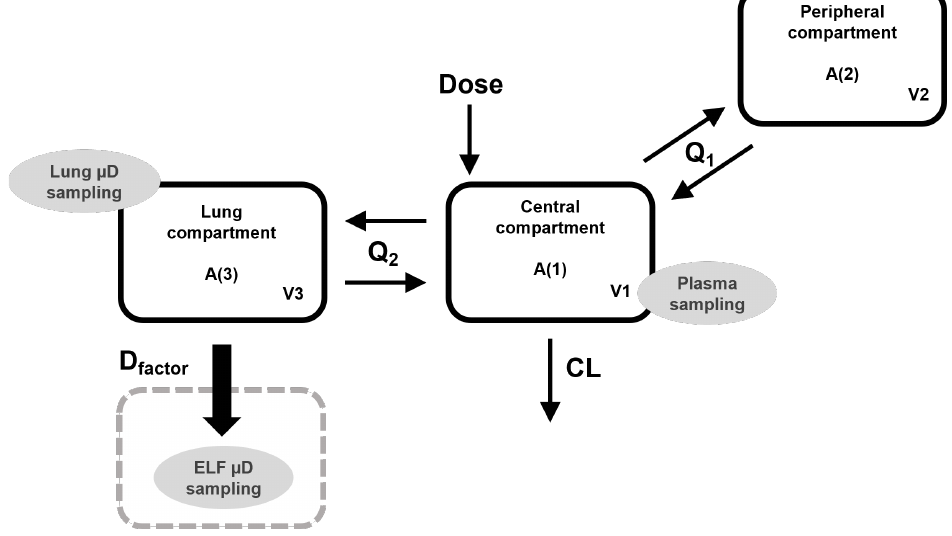
Figure 1. Schematic representation of the structure of the final TOB popPK model. Interindividual variability (IIV) was included in CL, V1, V3, and D factor . The SCM analysis demonstrated that the inclusion of chronic infected condition as a covariate in CL and V1 significantly increased the model fit compared to the base model. The parameters CL and V1 were estimated separately for the chronic infected group. The estimated CL and V1 were higher in animals with chronic infection (CL chronic = 0.085 L/h), compared to the healthy, acutely infected, and blank-bead groups (CL = 0.047 L/h). Acute, chronic, and blank-bead were included as covariates in V3, which was significantly increased compared to the healthy condition (0.130 L and 0.083 L, respectively). Table 1 shows the parameters estimated by the model, with a relative standard error (%RSE) no greater than 20%, and the 95th confidence intervals from the bootstrap analysis, that had 96% successful runs confirming the model stability. Table 1. Population pharmacokinetic parameters estimate for the popPK model. Parameter